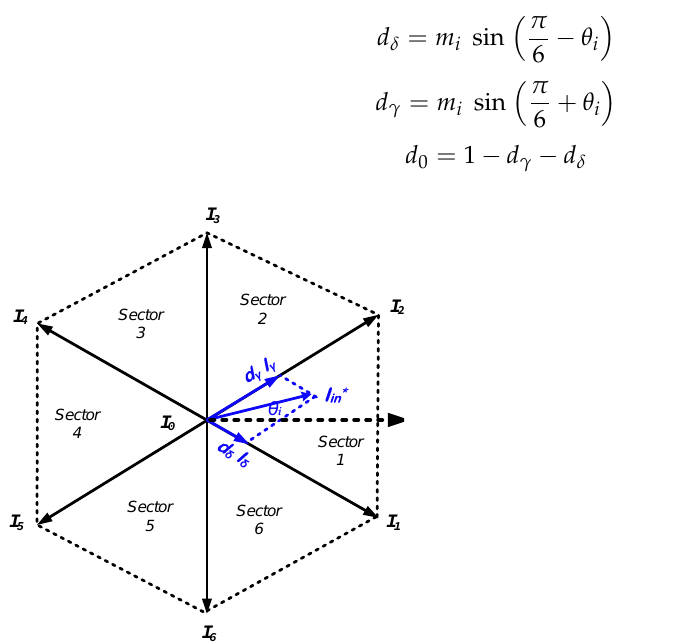
Figure 2. The hexagon of the controlled rectifier.